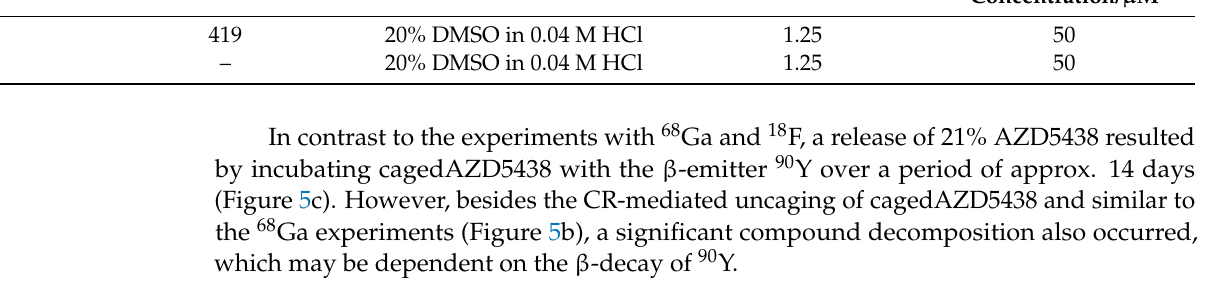
Table 4. Activation of cagedAZD5438 upon incubation with the beta minus emitter 90 Y ( N = 3). As positive controls, samples of cagedAZD5438 were irradiated with UV light, proving quantitative uncaging.